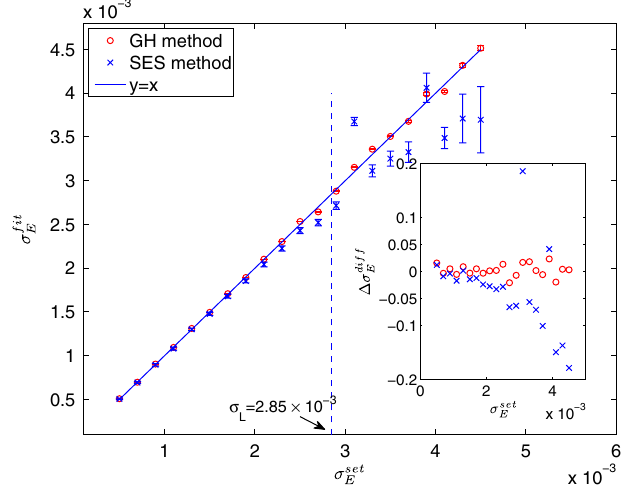
FIG. 3. (Color) Comparison of the fitted energy spread (cid:1) fit E and set energy spread (cid:1) set E . Parameters to generate simulated spectra ¼ 31 and (cid:3) ¼ 1 nm . The fitted are listed in Table I with N d x values of the energy spread using the G-H method are plotted as circles, while the fitted values using the SES method are plotted as crosses. The error bars show the RMS uncertainty of the fitting. The inset shows the relative difference between the fitted [Eq. and set values of the energy spread, (cid:1) (cid:1) diff E